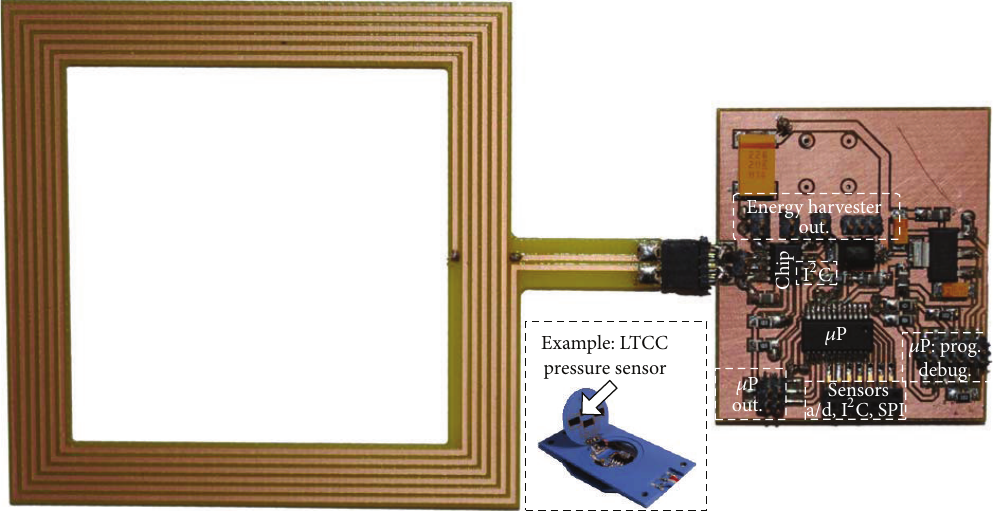
Figure 6: Practical realization of the transponder with harvester of additional energy.